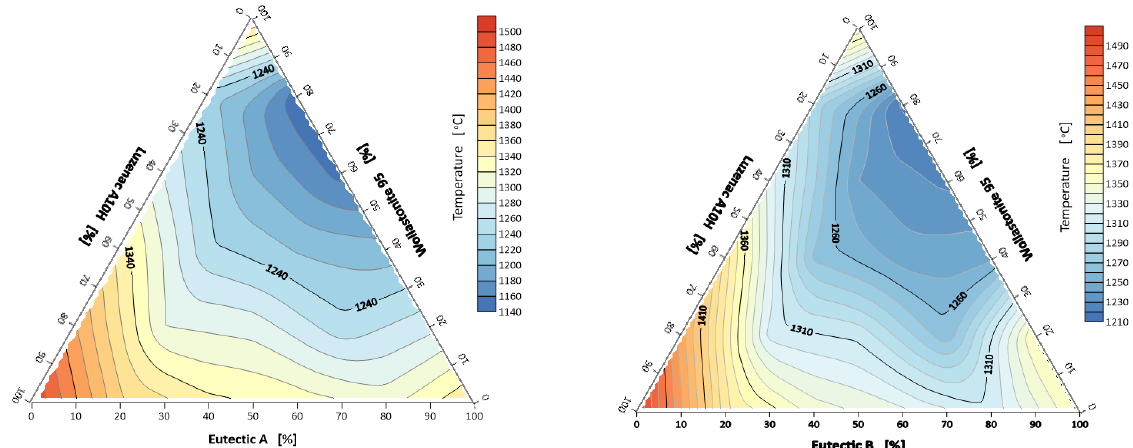
Figure 3. Melting points (hemisphere) of the system: A/B-eutectic–Luzenac A10H–Wollastonite 95. The first of the composition triangles: A-eutectic–talc–wollastonite, is characterized by the lowest spreading temperature of 1223 ◦ C at the point corresponding to the 60/0/40% composition, respectively. The highest melting temperature, i.e., 1429 ◦ C, was obtained for the composition of 20% A-eutectic and 80% talc (Figure 4). In the case of the system B-eutectic–talc–wollastonite, the lowest and the highest flow temperatures were recorded at different points than in the previous case. The lowest spreading temperature of 1227 ◦ C was recorded at the point corresponding to the composition of 60% B-eutectic, 20% talc and 20% wollastonite and the highest temperature of 1460 ◦ C was observed at the point of 100% B-eutectic. The measurements showed that also in this case, as the amount of talc in the composition increases, the melting temperature increases (Figure 4).